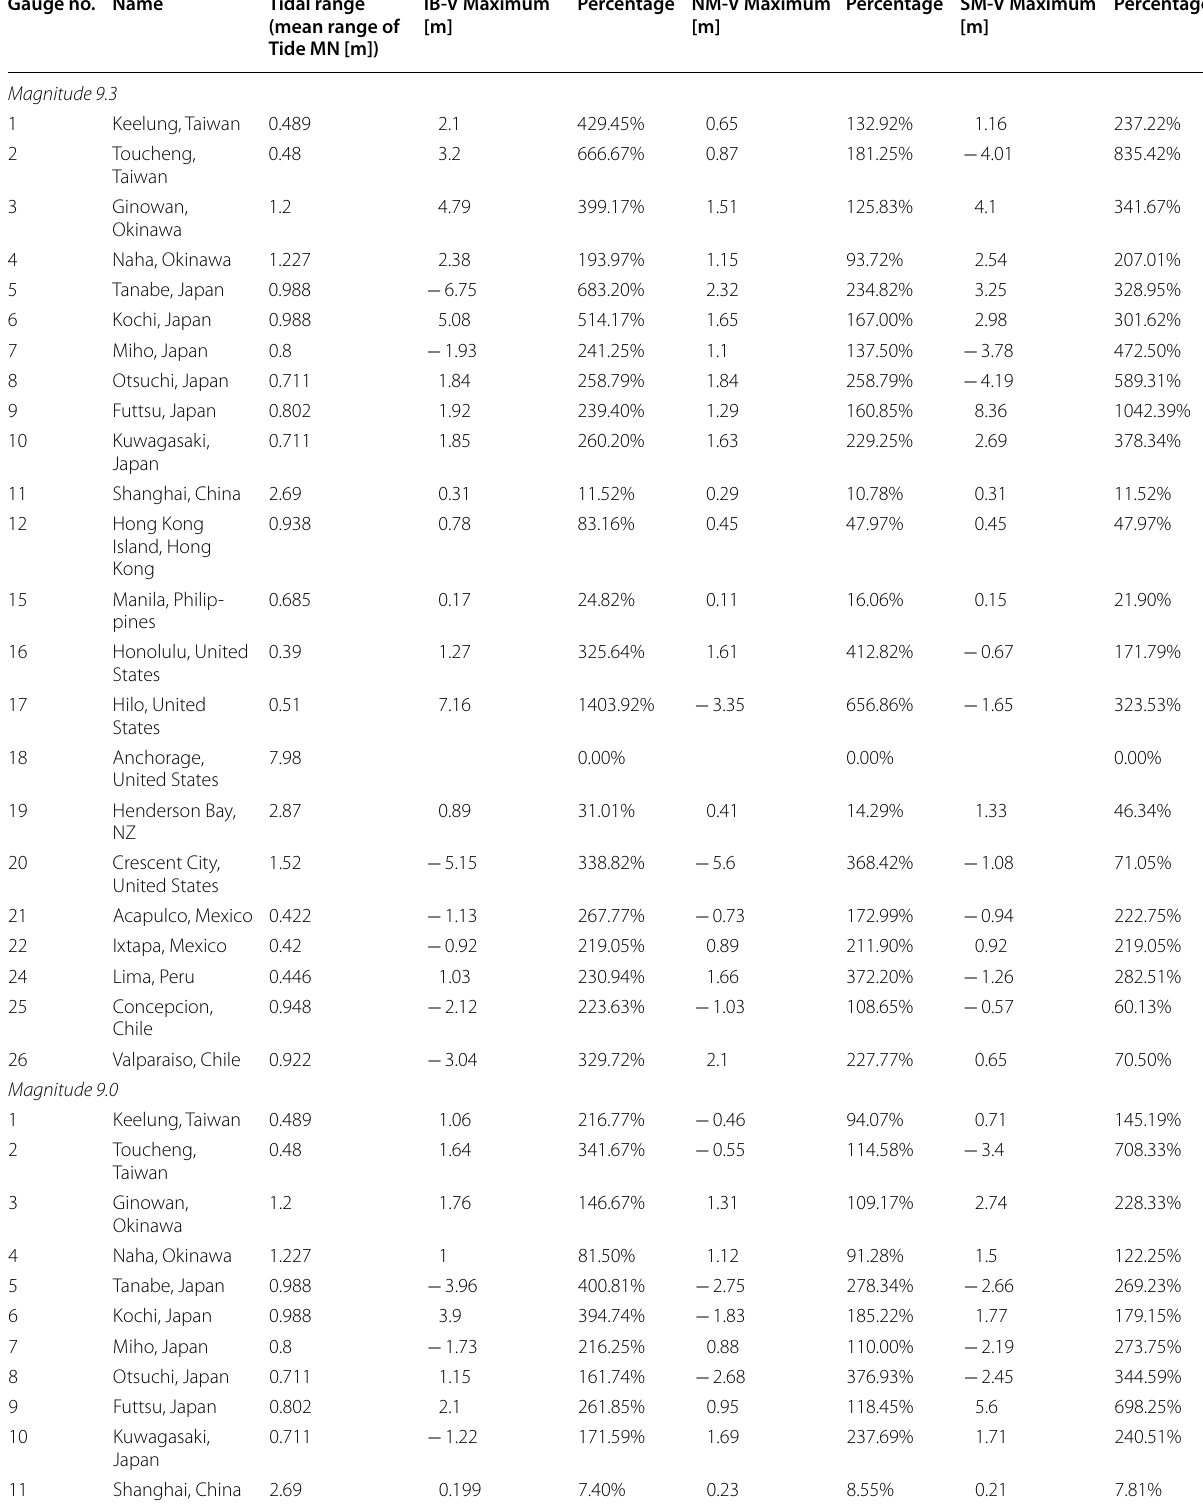
8.7, M 9.0, and M 9.3 earthquakes for each fault segment in the Izu–Bonin–Mariana w w w